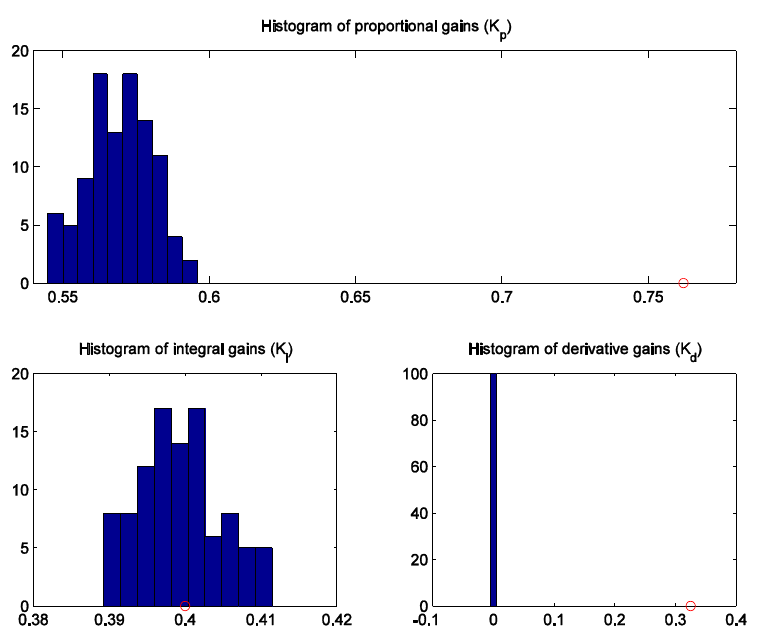
Figure 10. Histograms of the calculated controller parameters for 100 runs with noisy open-loop responses obtained using the WLS method. The values of the controller parameters obtained with undisturbed open-loop responses without noise are represented by red circles.